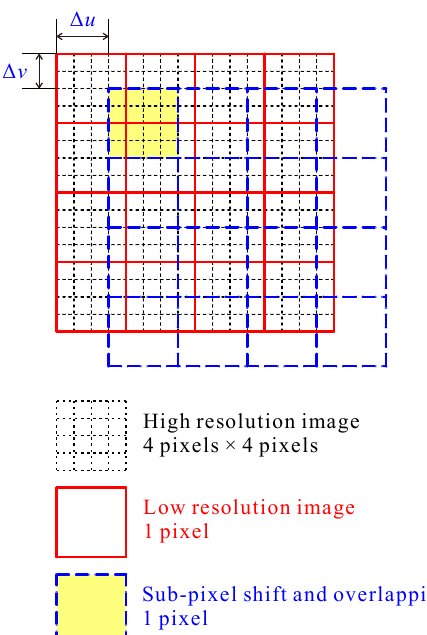
Figure 3. Sub-pixel shift and overlapping